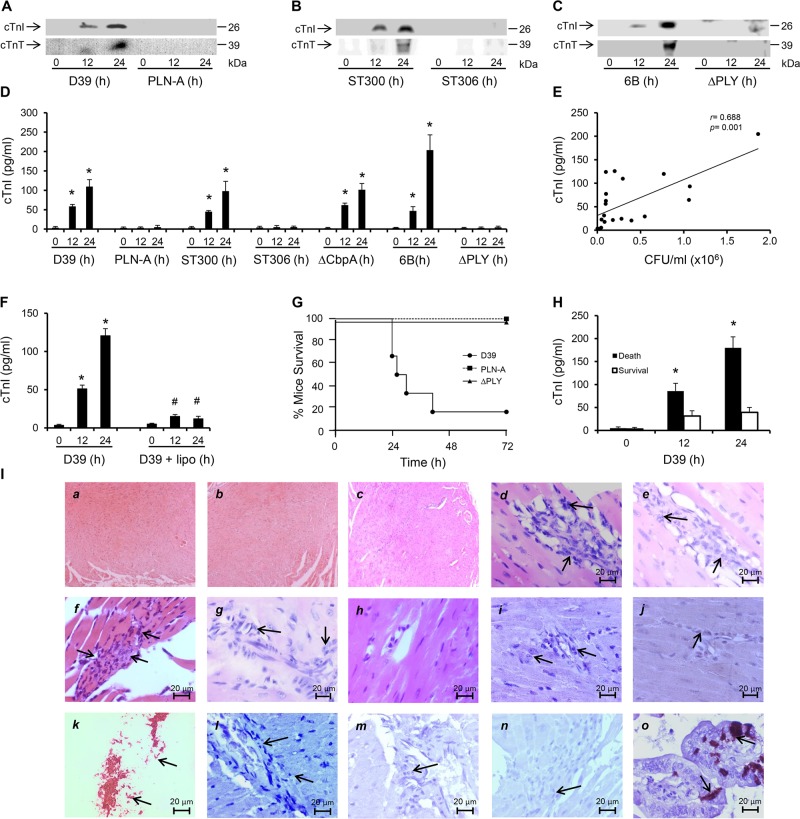
PLY-expressing but not PLY-deficient pneumococci induce cardiac injury and inflammation.(A-C) Representative Western blots showing circulating cTnI and cTnT in murine plasma following i.v. injection of D39/PLN-A (n = 4) (1x106 CFU) (A) serotype-1, sequence type 300 and 306 (n = 5) (1x106 CFU) (B), and serotype 6B and PLY-deletion pneumococci (ΔPLY) (1x106 CFU) (C). (D) Mean±SD of circulating cTnI from 4 mice (each group) that survived at 24 h after treatment with D39, PLN-A, ST300, ST306, ΔCbpA, 6B and ΔPLY (1x106 CFU each). *p<0.05 as compared to 0 h. (E) Linear correlation between pneumococcal CFU counts and circulating cTnI levels at various time points (n = 21). (F) Circulating levels of cTnI in plasma of mice following i.v. injection of D39 (1x106 CFU) with or without liposomes (lipo). (n = 3 each group). *p<0.05 as compared to 0 h, #p<0.05 as compared to D39 group. (G) Survival curves of mice infected (i.v.) with D39,PLN-A and ΔPLY (n = 10 for D39, n = 5 for PLN-A, n = 4 for ΔPLY). (H) Circulating levels of cTnI in plasma of mice that died and those that survived within the first 30 h post-D39 infection (n = 4 each group). *p<0.05 as compared to survival group. (I) Pathological examination of murine heart sections after infection with D39, serotype-1, serotype 6B and ΔCbpA pneumococci. H&E representative images (a-h) of murine heart sections under x4 magnification (a-c) and x60 magnification (d-h). Hearts from mice infected with D39 (30 h post infection, d), serotype-1 (e), 6B (f) and ΔCbpA (g) show inflammatory cell infiltration (arrows) at x60 magnification, these are absent in a normal heart section (h). (i-j) Immunohistochemistry images showing absence of pneumococcal capsule staining in heart from mice infected with D39 (i) and serotype-1 (j), despite presence of inflammatory cell infiltrations (arrows). (k) Fresh pneumococci (D39) (arrows) were stained in parallel, as a positive control for pneumococcal capsule staining. (l-n) Representative immunohistochemistry images showing absence of active caspase-3 staining in heart section from mice infected with D39 (l), serotype-1 (m) and 6B (n) despite presence of inflammatory cell infiltrations (arrows). (o) Gut microvilli of a septic mouse showing positive active caspase-3 signal (arrows), was used as a positive control for active caspase-3 staining.